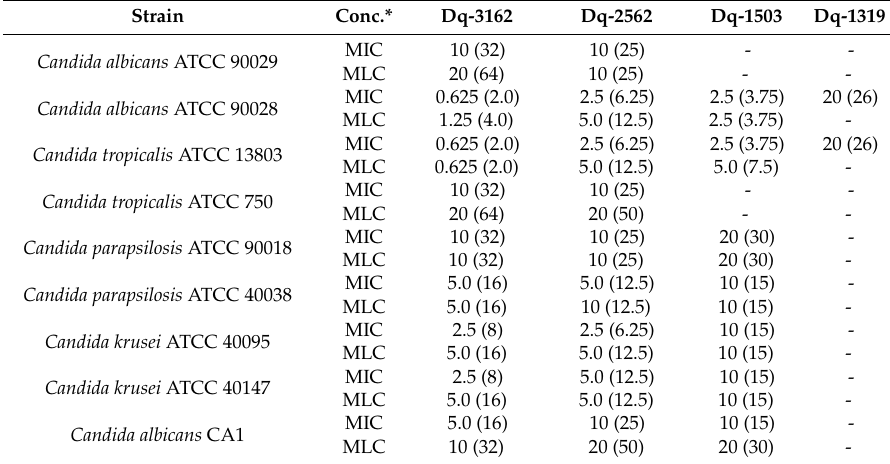
Table 2. Minimum inhibitory concentration (MIC) and minimum lethal concentration (MLC) of synthetic pilosulin- (Dq-2562, Dq-1503, and Dq-1319) and ponericin-like (Dq-3162) peptides from the giant ant D. quadriceps venom against Candida